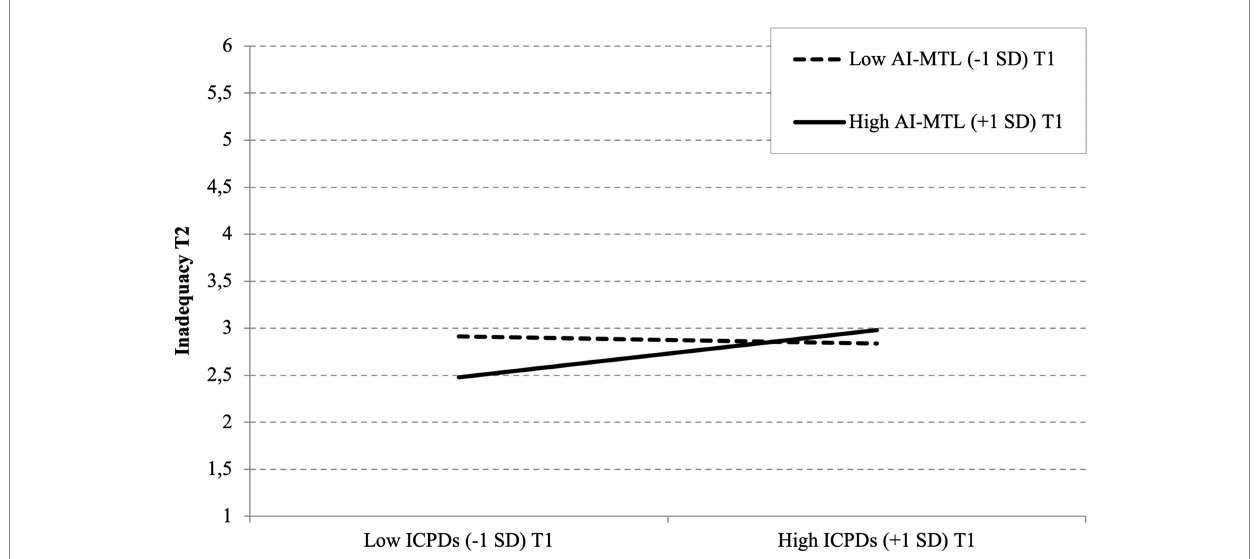
FIGURE 3 Two-way interaction effect between affective-identity motivation to lead (AI-MTL) at T1 and intensified career-related planning demands (ICPDs) at T1 on inadequacy at T2 ( B coefficients are reported in the